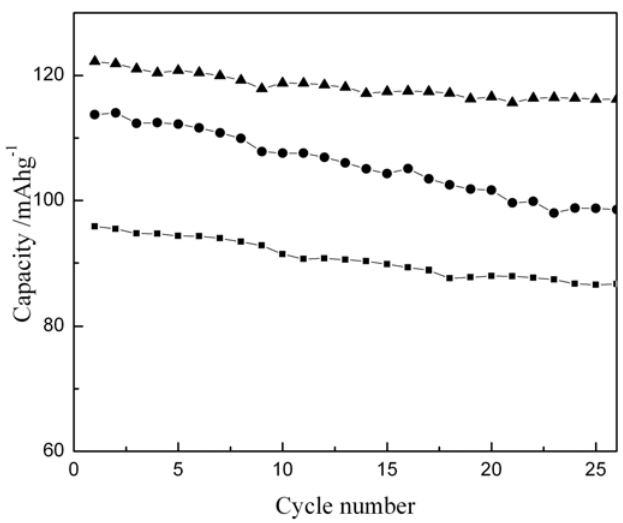
Figure 6. Discharge capacity versus cycle number for Li/LiCoO 2 cells cycled between 3.5- 4.2 V at room temperature ( ~30 ºC ) with LiCoO 800 ºC, - ▲ - 700 ºC and - ■ -600 ºC.